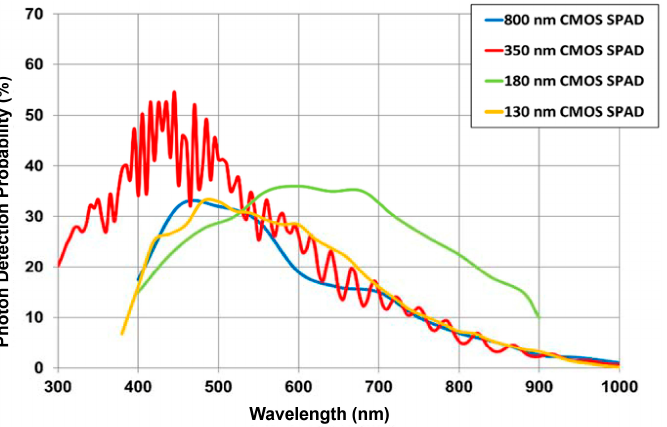
Figure 4. Photon detection probability of SPADs fabricated in different technologies (from [24]).